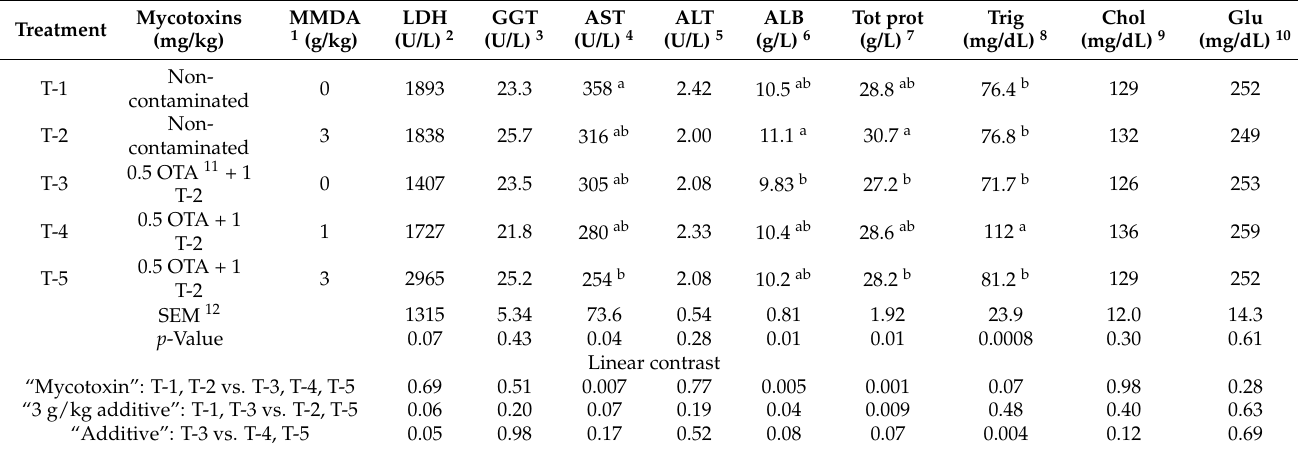
Table 4. The effects of feeding ochratoxin A (OTA) and T-2 mycotoxins and the addition of a binder mycotoxin product (MMDA) on blood biochemistry of broiler chickens.